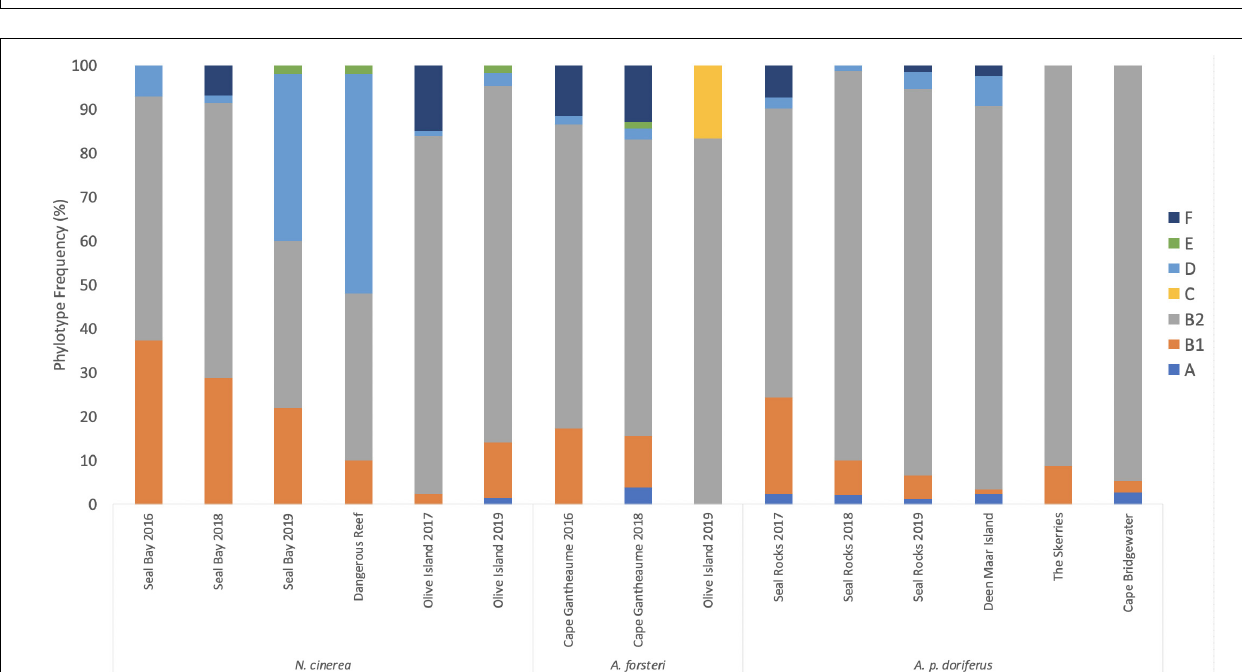
FIGURE 2 | Distribution of E. coli phylotypes in each species across all breeding seasons (2016–2019).